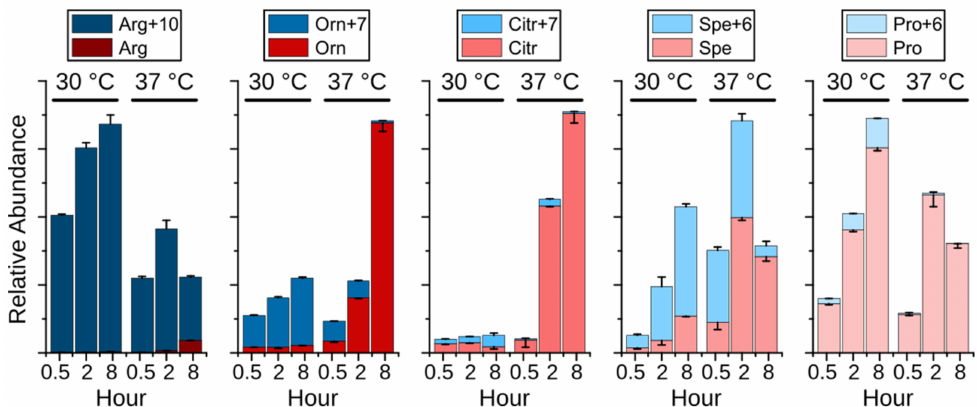
Figure 5. Relative abundance (mean +/ - standard derivation, the error bars are displayed for the upper portion in plus and the lower portion in minus) of labeled arginine (Arg + 10) and nonlabeled arginine (Arg) and the related metabolites labeled ornithine (Orn + 7) and ornithine (Orn), labeled citrulline (Citr + 7) and citrulline (Citr), labeled spermidine (Spe + 6) and spermidine (Spe), labeled proline (Pro + 6) and proline (pro). The cells were grown at either 30 ◦ C or 37 ◦ C for 0.5, 2, or 8